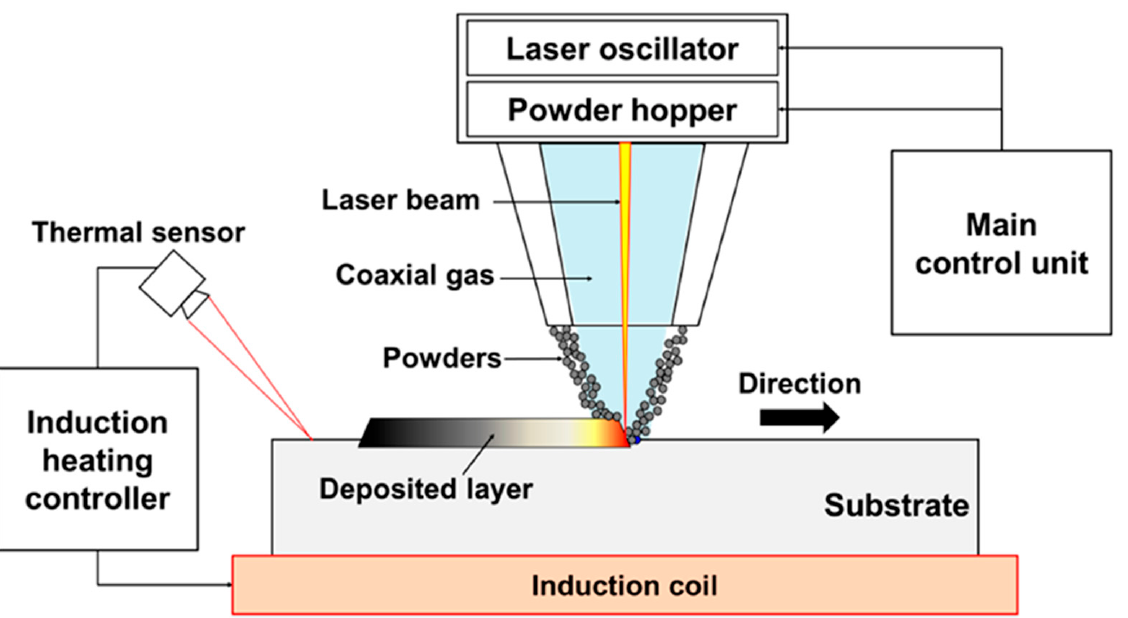
Figure 6. Schematic of the laser powder bed fusion process. Reprinted with permission from Ref. [60]. Copyright 2019 by the authors and licensee MDPI, Basel,